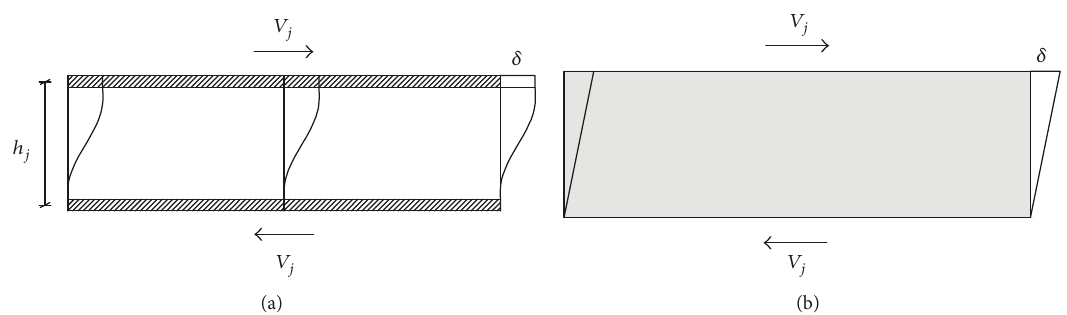
Figure 5: Model used for calculating the translational stiffness of the equivalent shear-deflecting cantilever beam. (a) A shear-type frame story; (b) a continuous element of the same length, subjected to the same shear of the scheme on